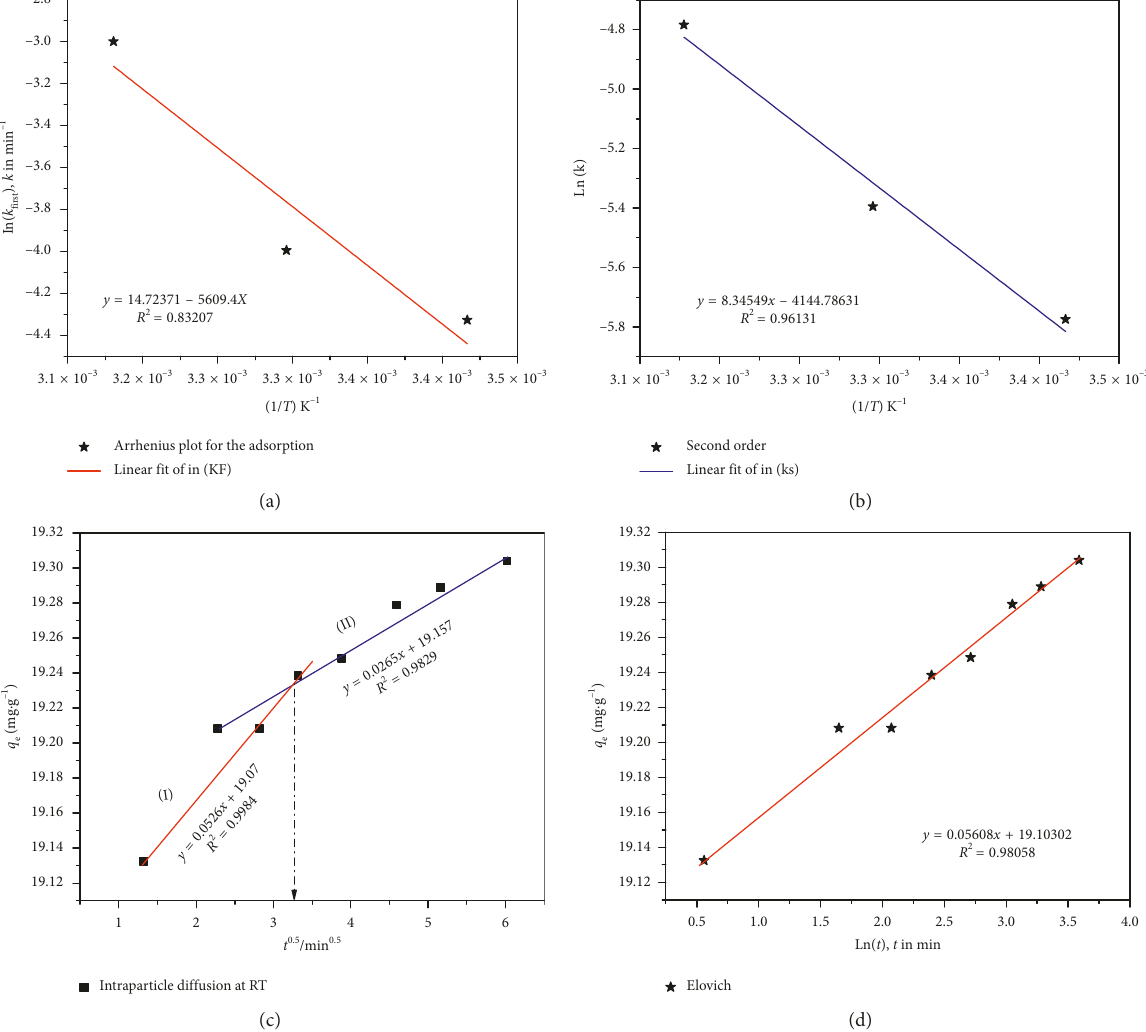
Figure 13: Arrhenius plots of (a) adsorption process (first order), (b) Cd(II) consumption (second order), (c) Weber-Morris, and (d) Elovich